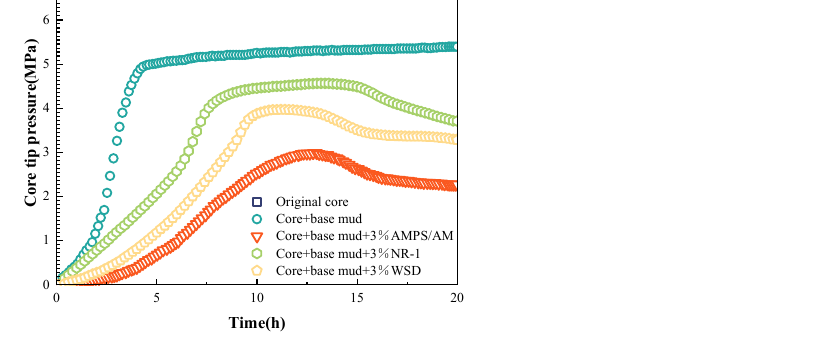
Table 1. Hardness test results of cores before and after replacement.